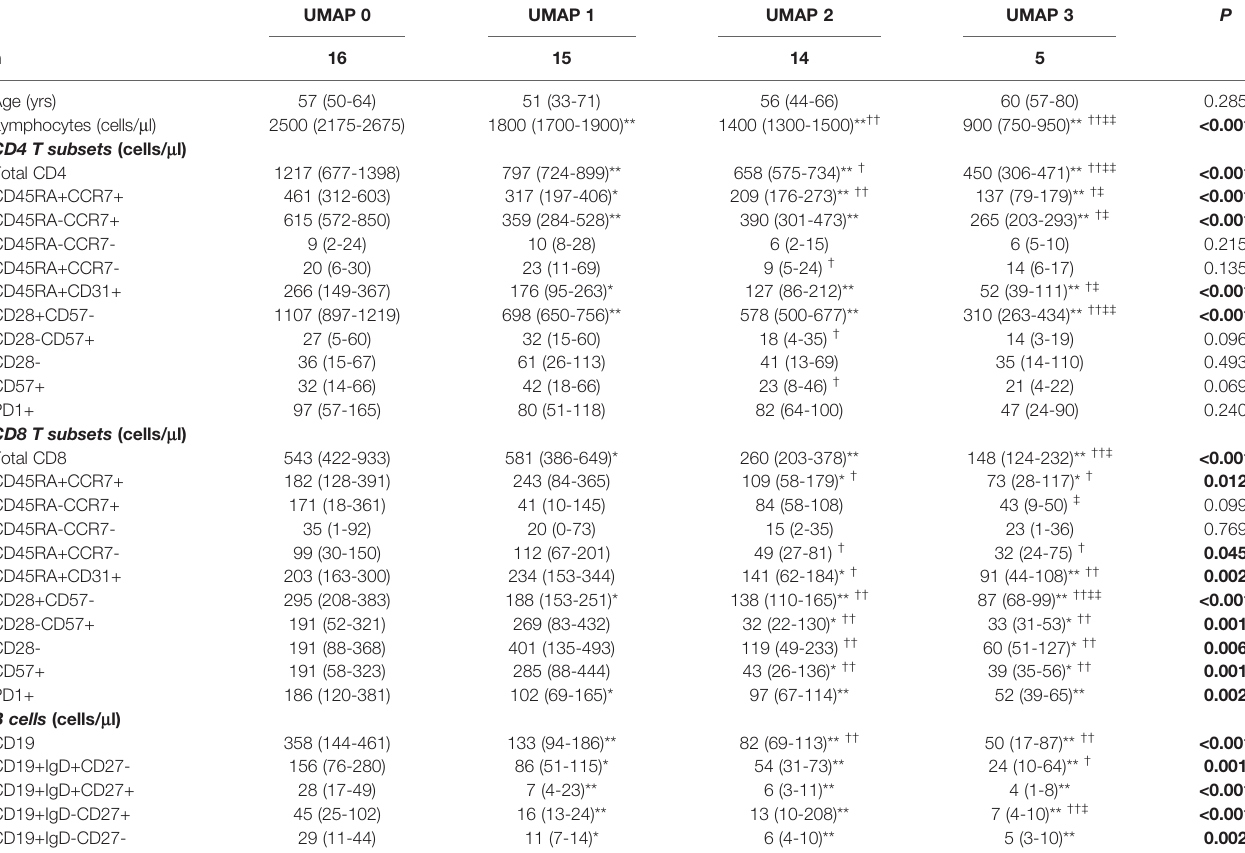
TABLE 5 | CD4, CD8 and B cells subsets count based on clustering of ESRD groups according to UMAP.